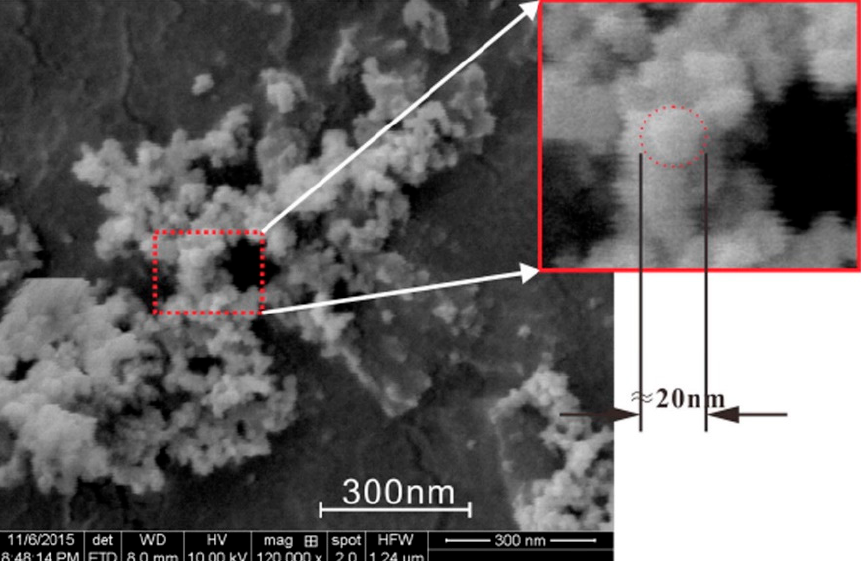
Figure 4. Micrograph of nano-silica [86]. Table 2. Physical properties of nano-silica from the literature.